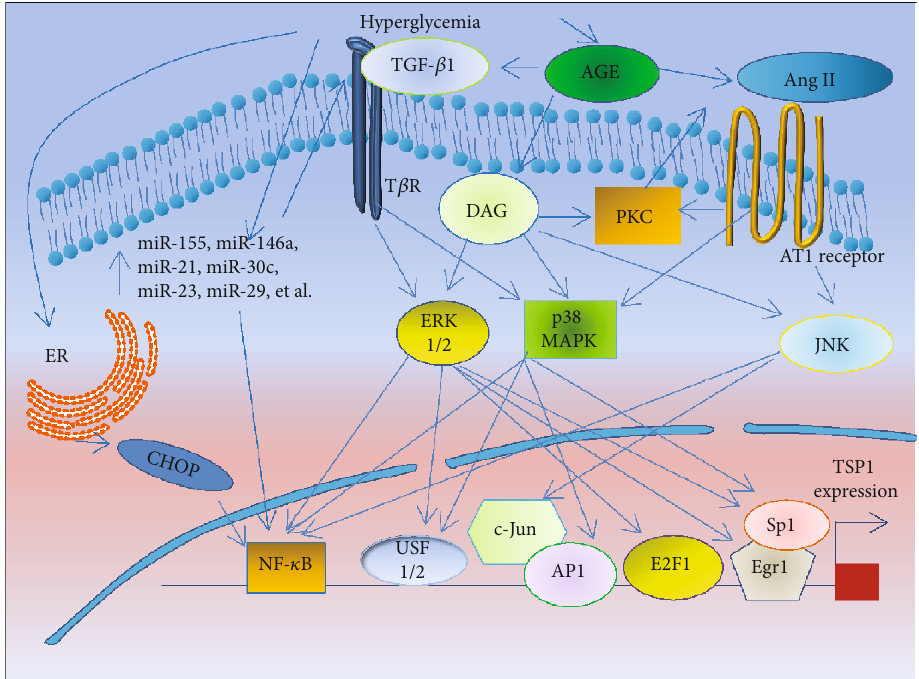
Figure 2: The activation of pathways triggered by hyperglycemia to induce TSP-1 expression. This diagram shows the pathways of PCK and Ang II induced by AGE; in addition, PKC also directly enhances Ang II activity. Then, two pathways induce some transcription factors binding the TSP-1 promoter to enhance the expression of TSP-1 via the MAPK pathway. ER stress and miRNAs also induce the expression of TSP-1 via activating NF- κ B signaling. AGE: advanced glycation end products; DAG: diacylglycerol; PKC: protein kinase C; Ang II: angiotensin II; AT1: Ang II type 1; MAPK: mitogen-activated protein kinase; JNK: c-Jun amino terminal kinase; ER: endoplasmic reticulum; ERK: extracellular signal-regulated kinase; USF1/2: upstream stimulatory factors 1/2; Sp1: stimulating protein; NF- κ B: nuclear factor-kappa B; Egr1: early growth response 1; AP1: activator protein